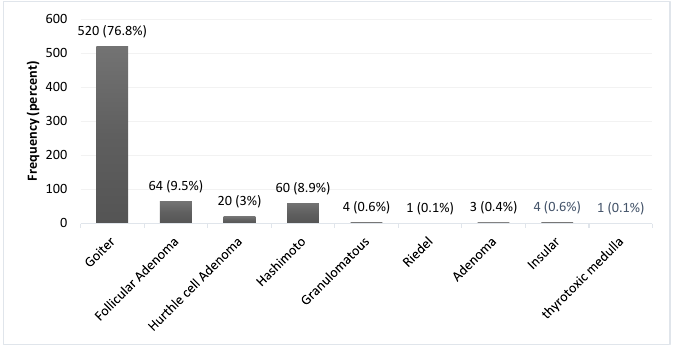
Figure 1. Frequency distribution of benign thyroid cancer